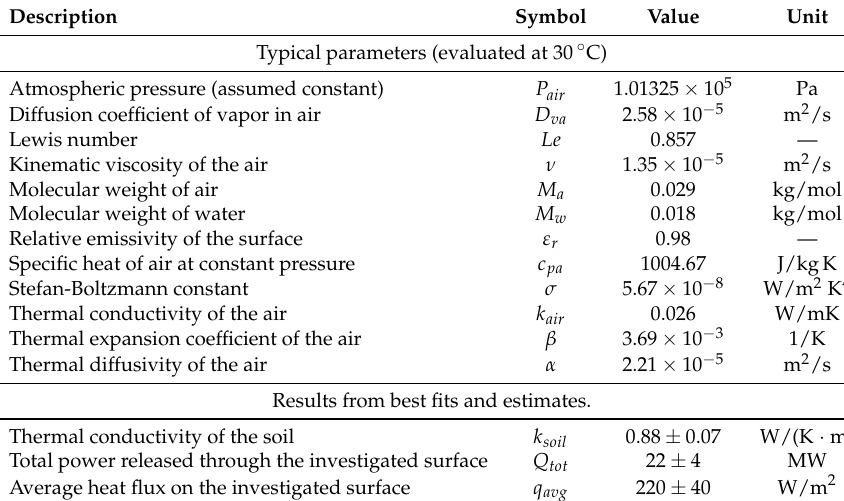
Table 2. Parameters and